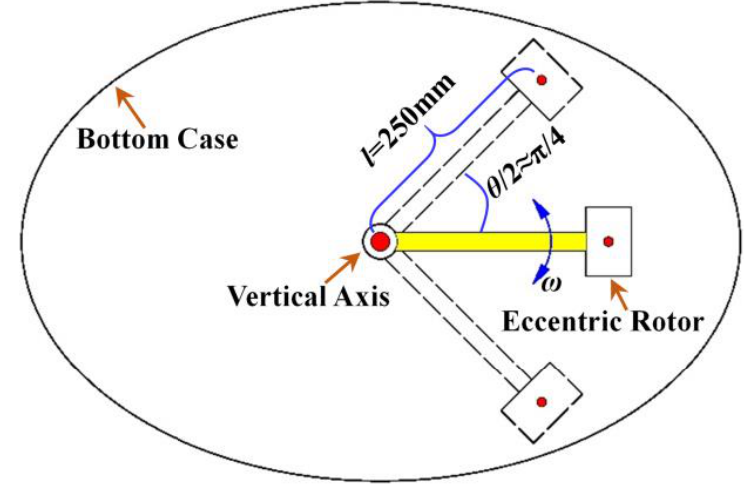
Figure 4. Oscillating law of eccentric rotor.